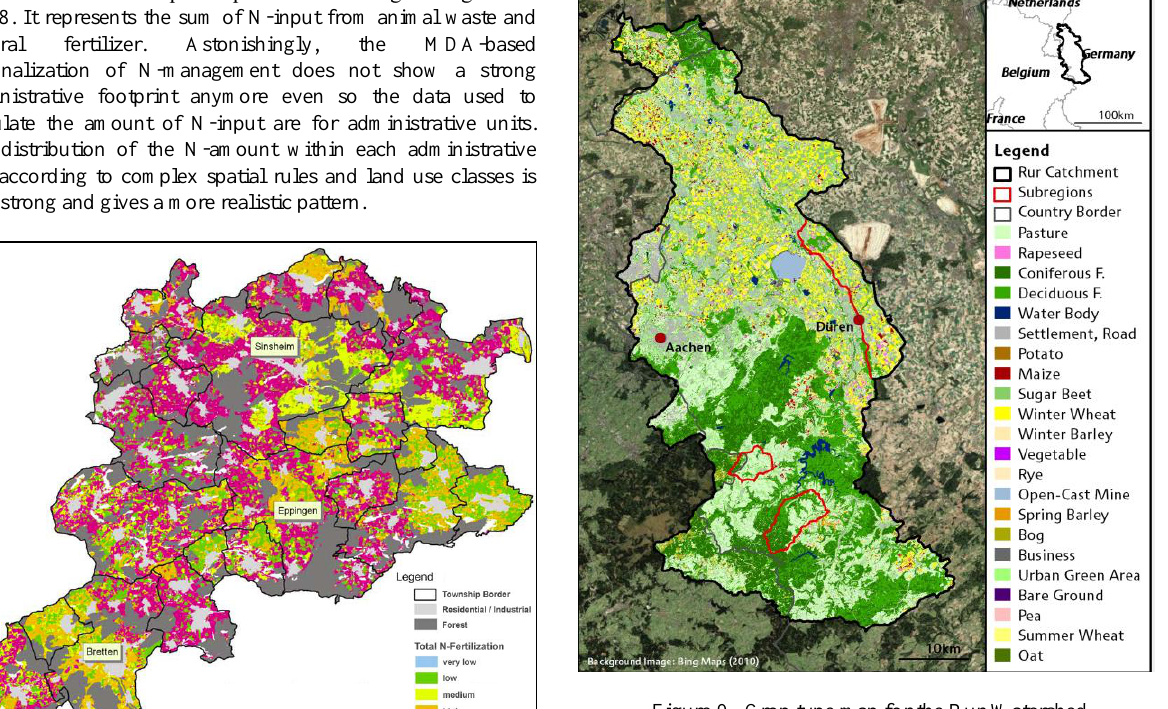
Figure 9. Crop type map for the Rur-Watershed (Waldhoff et al., 2011)